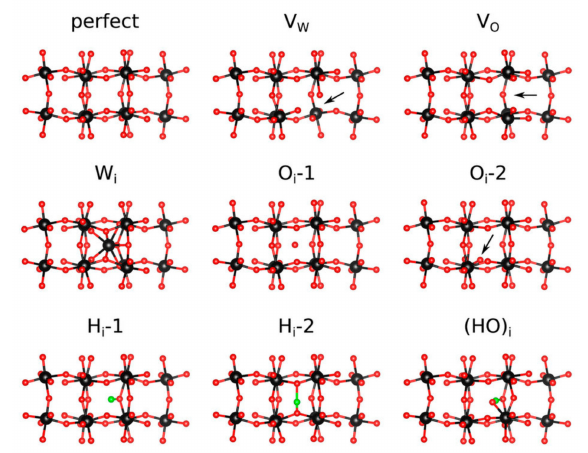
Figure 8. Configurations of defects in WO 3 considered using density functional theory by Zhu et al. [76]. W, O, and H atoms are represented by black, red, and green spheres, respectively.